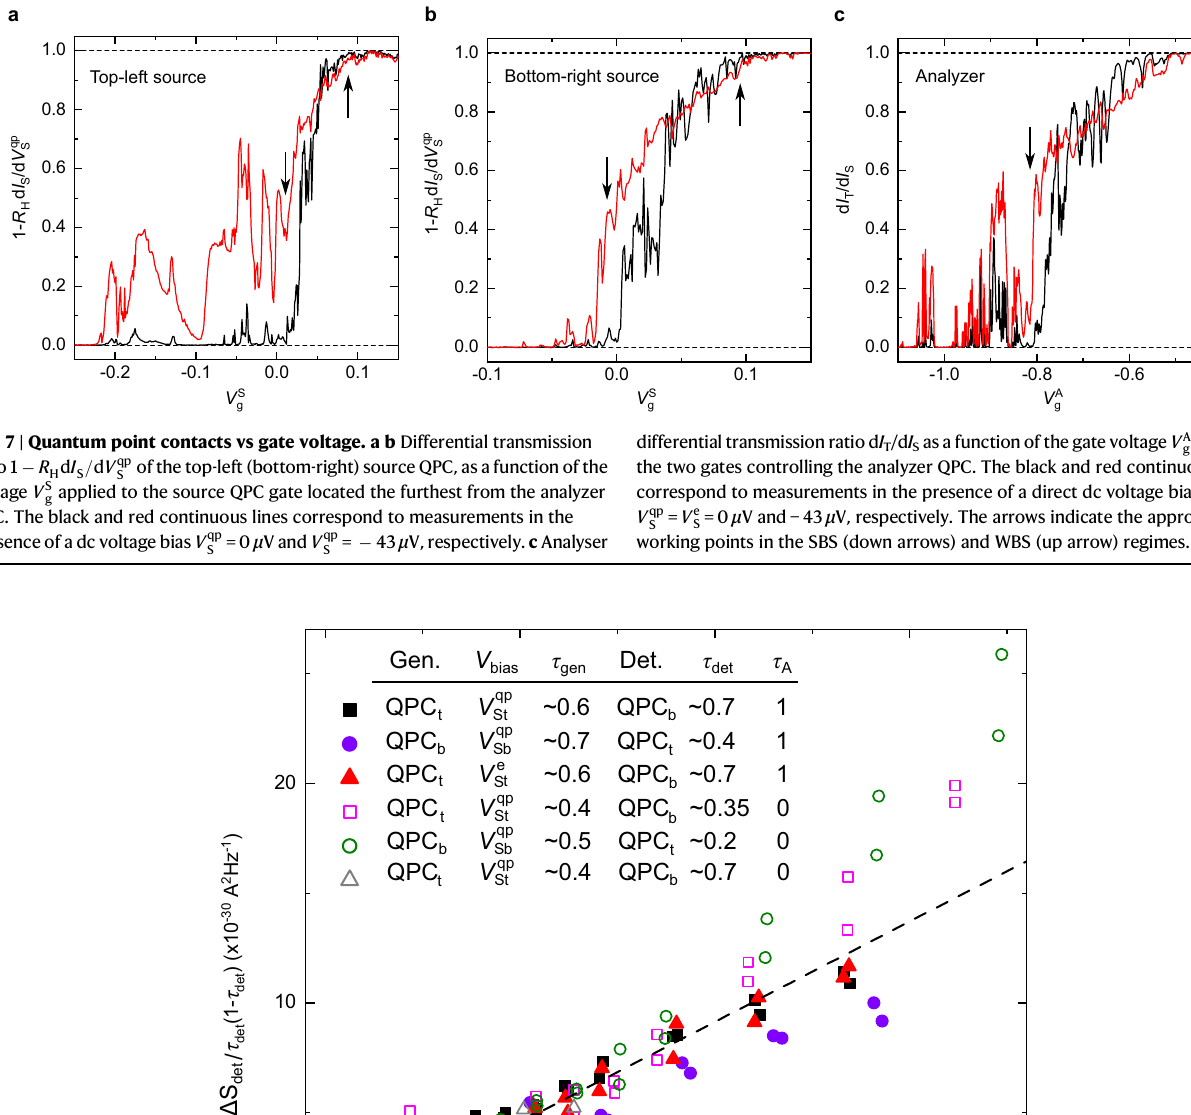
Fig. 8 | Nonlocal heating. The normalized noise increase Δ S det = ð τ det ð 1 (cid:3) τ det ÞÞ emittedfrom anun-biased`detector ’ source QPC t(b) of transmission τ det is plotted as a function of the power P inj injected at a second `generator ’ source QPC b(t) of transmission τ gen (t and b indexes stand for the top-left and bottom-right QPCs, respectively). The detector and generator are electrically separated by chirality,